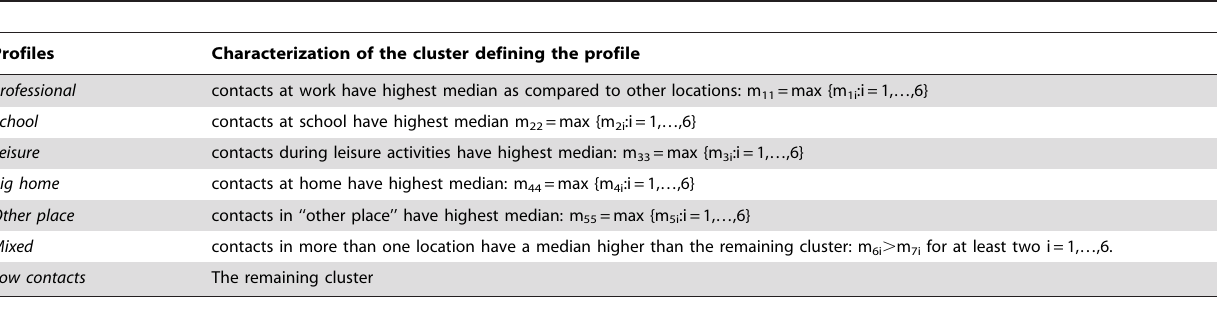
Table 2. Definition of the contact profiles: For every cluster the distribution of (n 1 ,…, n 6 ) was determined based on all respondents in that cluster.